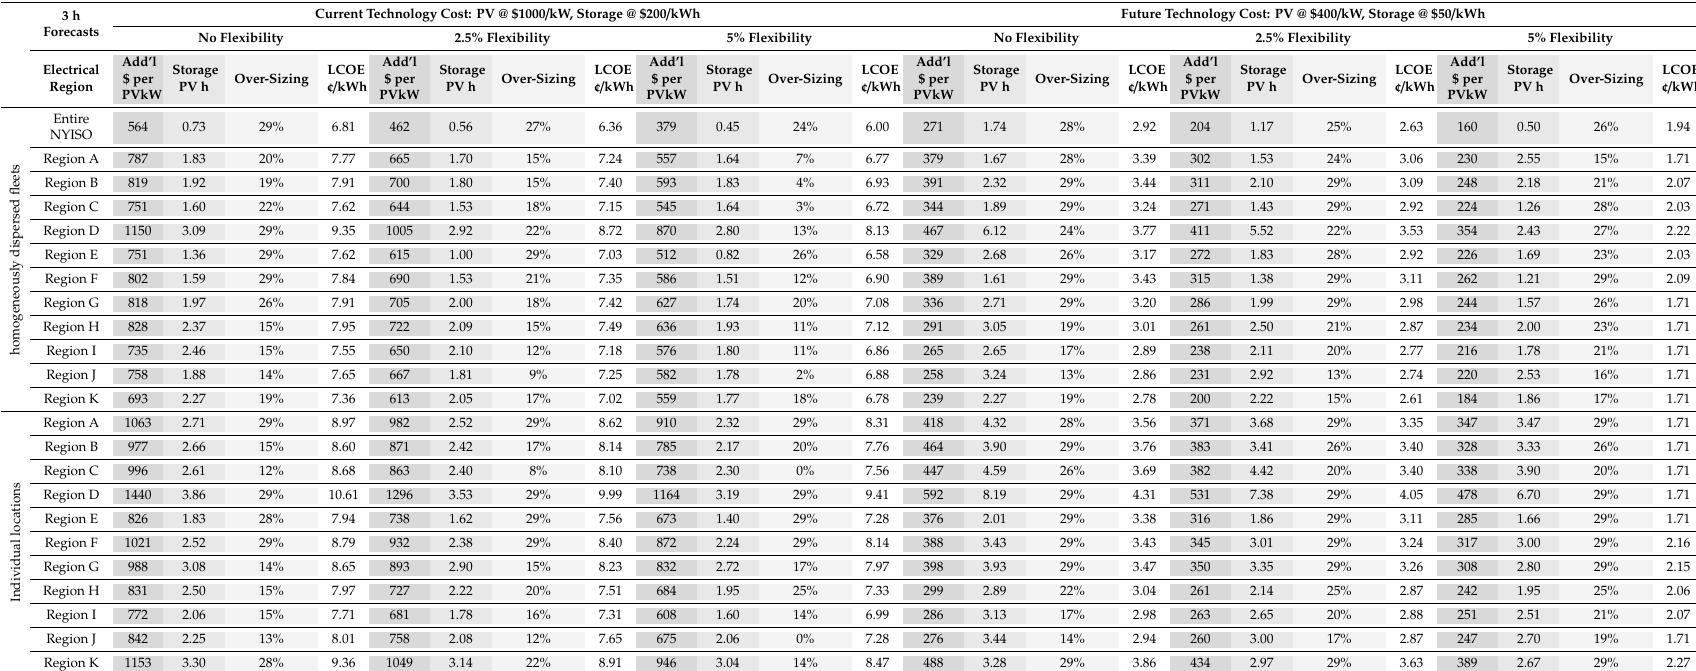
Table A5. Three-hours-ahead firm forecast results applying